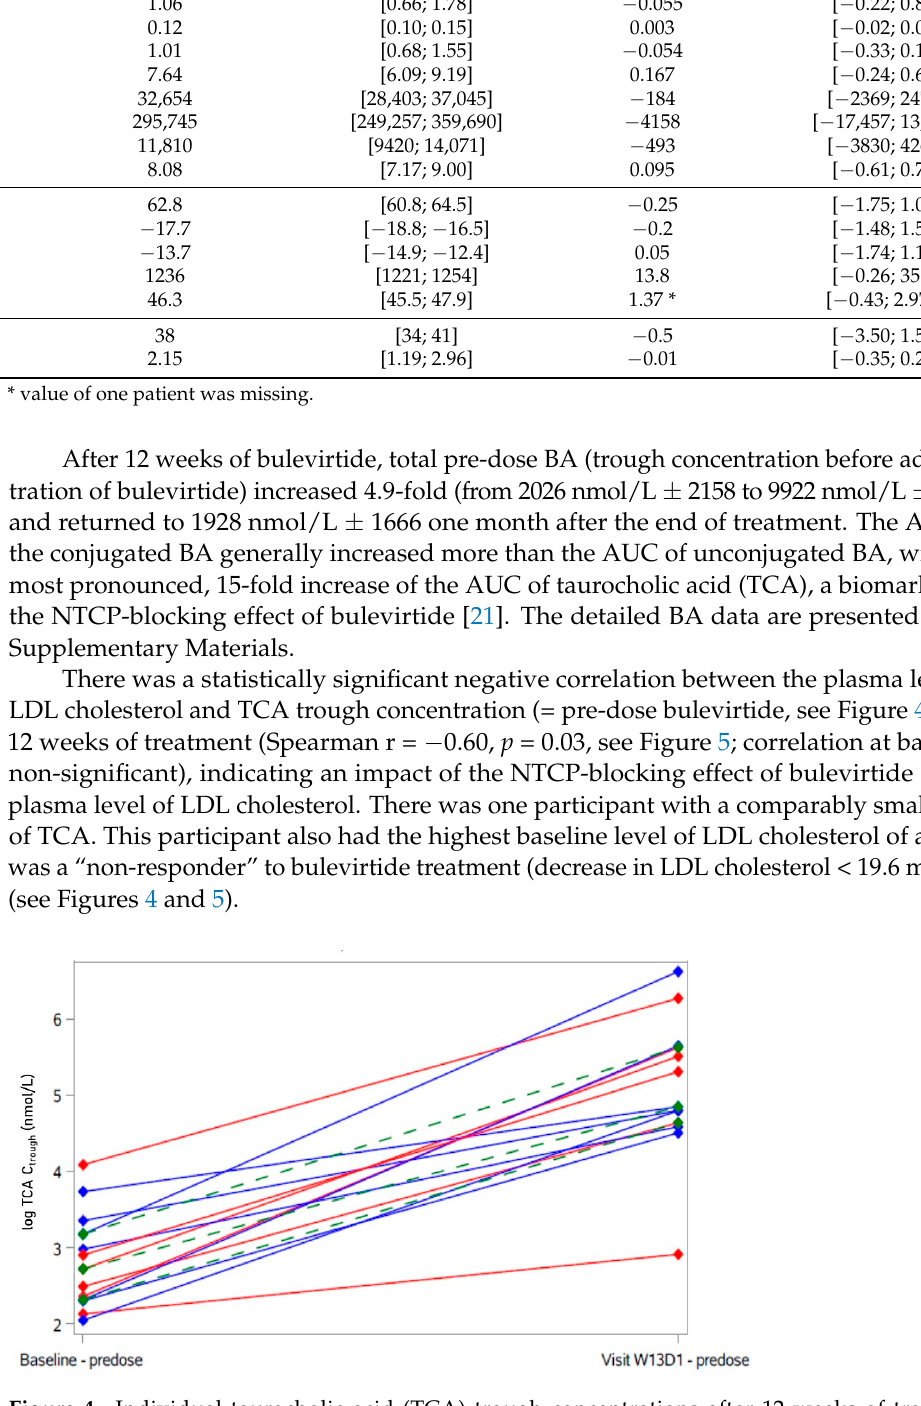
Figure 5. Correlation between taurocholic acid (TCA) trough concentrations and plasma LDL cho- lesterol at baseline (open circles) and after 12 weeks (closed circles) of treatment with bulevirtide (Spearman r = − 0.60; p = 0.03 for values after 12 weeks, closed circles). Participants with decrease of LDL cholesterol > 19.6 mg/dL in blue (“responder”); participants with no decrease and decrease < 19.6 mg/dL of LDL cholesterol in red (“non-responder”). The pharmacokinetic parameters of bulevirtide have been published separately [22]. 2.4. Safety Assessment Bulevirtide was well tolerated. Sixty-eight adverse events were observed (mild: n = 52, moderate: 13, severe: 3 (blood pressure increased, syncope, lipase increased; all re- solved)). Causality with investigational medicinal product (IMP) was assessed as definite in 11 cases, probable in 10 cases, and possible in 9 cases. General disorders and admin- istration site conditions (e.g., injection site haematoma, erythema, pruritus, pallor) were